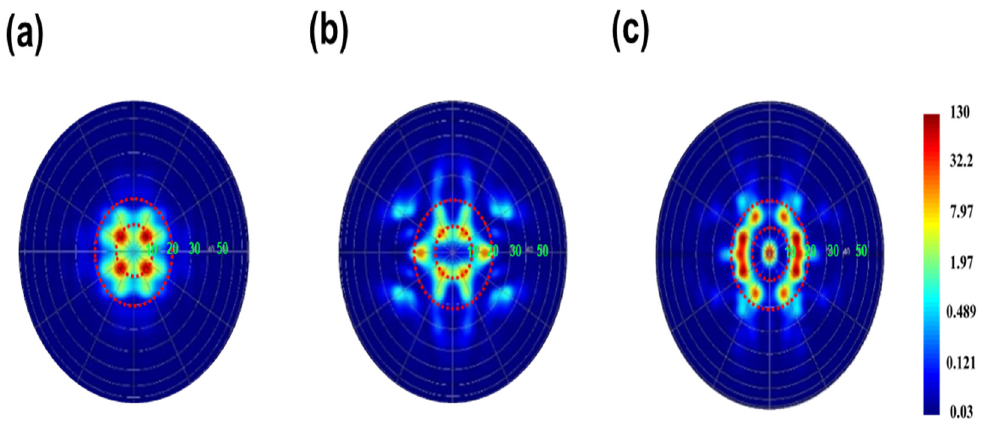
Figure 6. Far-field intensity mappings of ( a ) a reference LED and LEDs with ( b ) An-TiO 2 and ( c ) Am-TiO 2 NS monolayers.